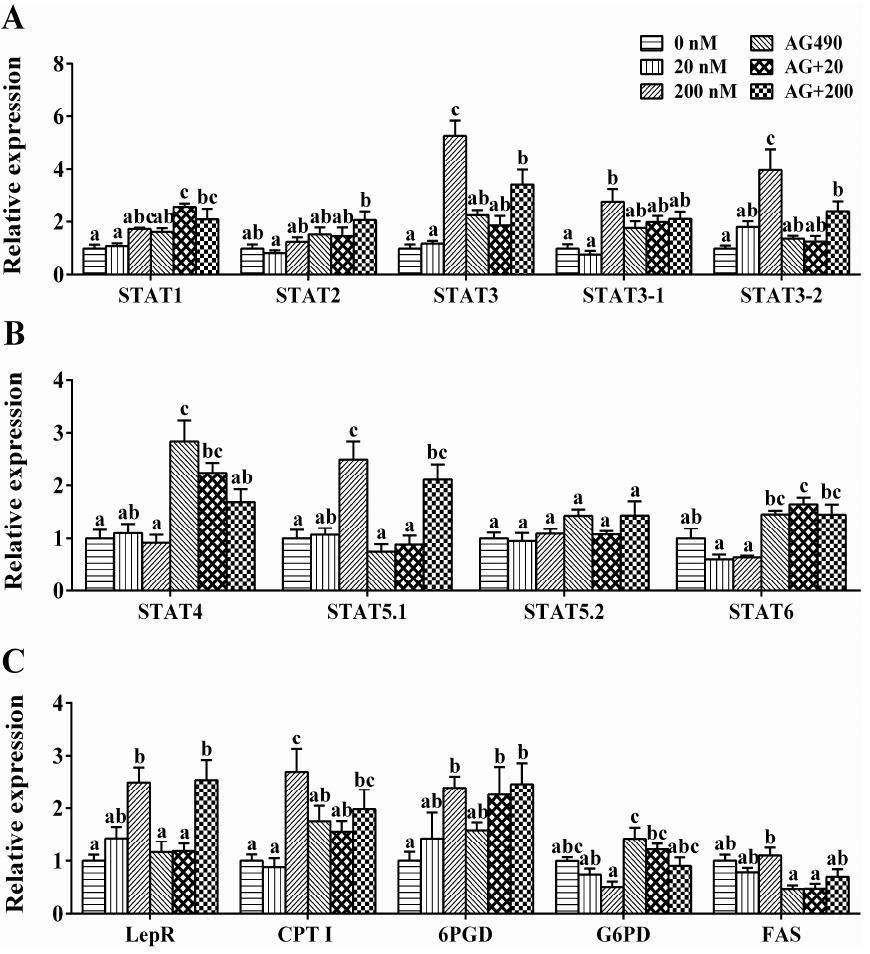
Figure 6. Effects of leptin and/or pathway inhibitor AG490 on the mRNA levels in the hepatocytes of S. hasta in vitro at 48 h. ( A ) STAT1-3; ( B ) STAT4-6; and ( C ) LepR and genes involved in lipid metabolism. Data (mean ± SEM, n = 4) were expressed relative to expression of housekeeping gene ( RPL7 and TBP ). Bars that share different lowercase letters indicate significant differences among groups ( p < 0.05).